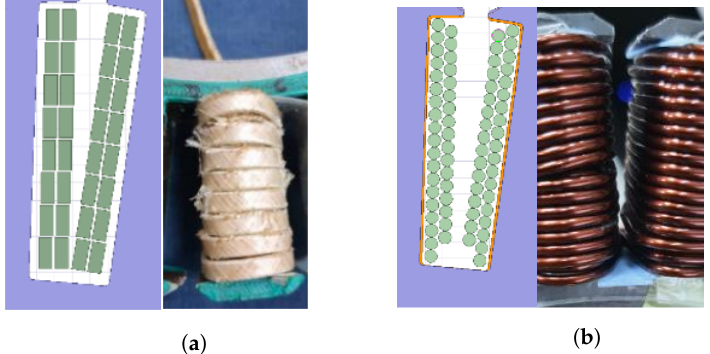
Figure 13. Stator windings. ( a ) Single flat winding ( b ) Two parallel round